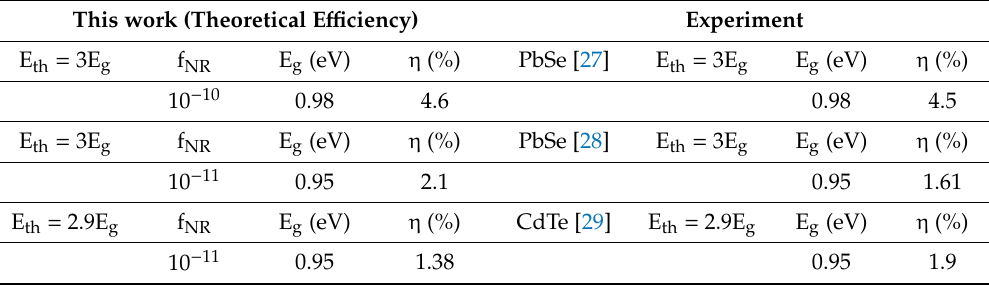
Table 1. Comparison between theoretical e ffi ciency and experimental e ffi ciency of an